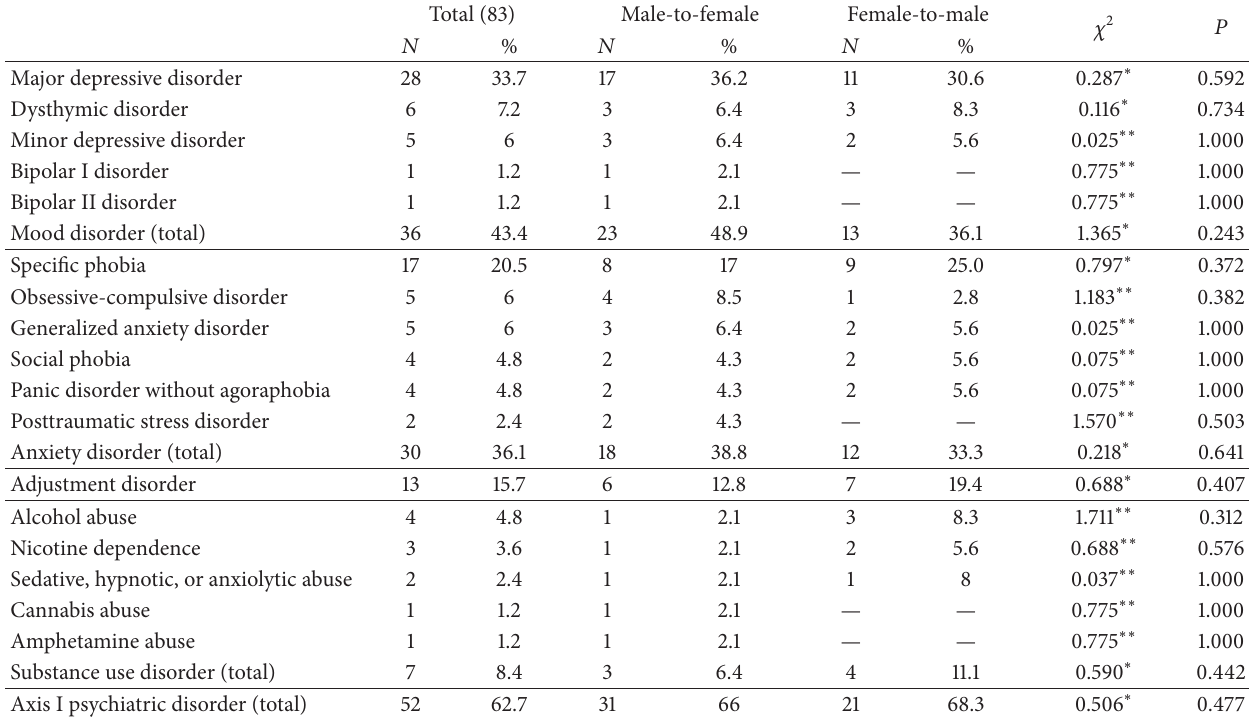
Table 1: Prevalence rates of lifetime DSM Axis I psychiatric comorbidities in patients.